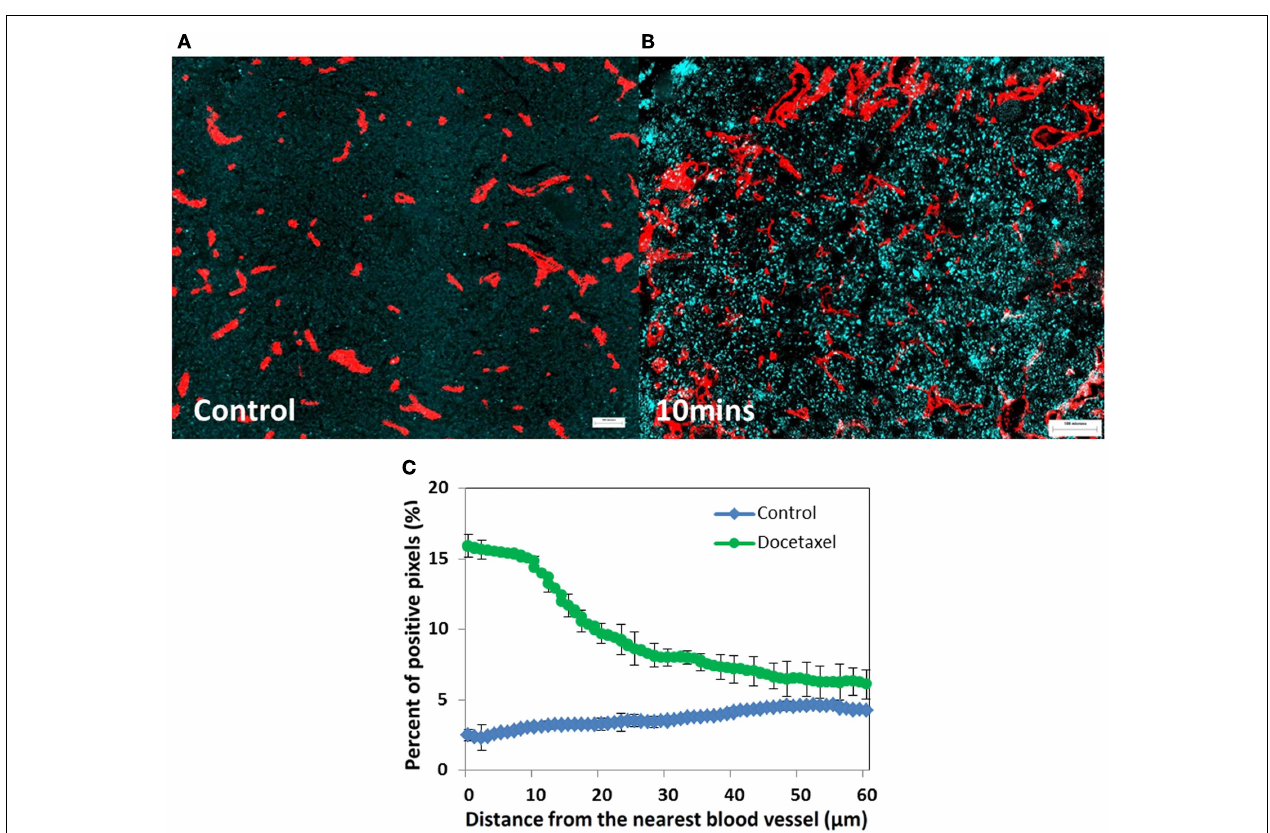
distribution of γ H2aX-positive cells in relation to the nearest blood vessel in tumors treated with docetaxel for 10min (green line) and untreated controls (blue line). Points indicate average of six mice per group; bars, SE. ♦ : control; ◦ :